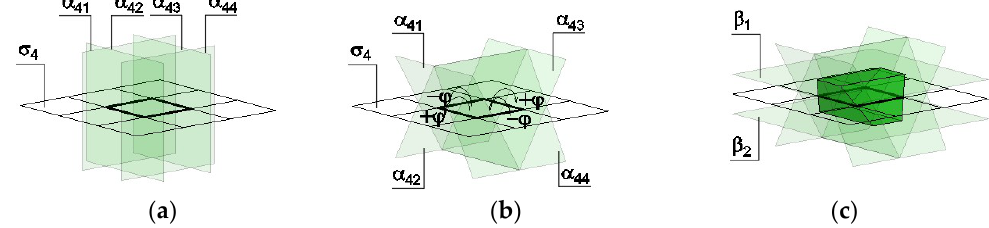
Figure 2. The procedure of modeling a vault component based on a square: ( a ) establishment of a grid of squares σ 4 and insertion the planes α 4 j perpendicular to it; ( b ) rotations of the planes α 4 j ; ( c ) final determination of a component shape with the use of planes β 1 and β 2